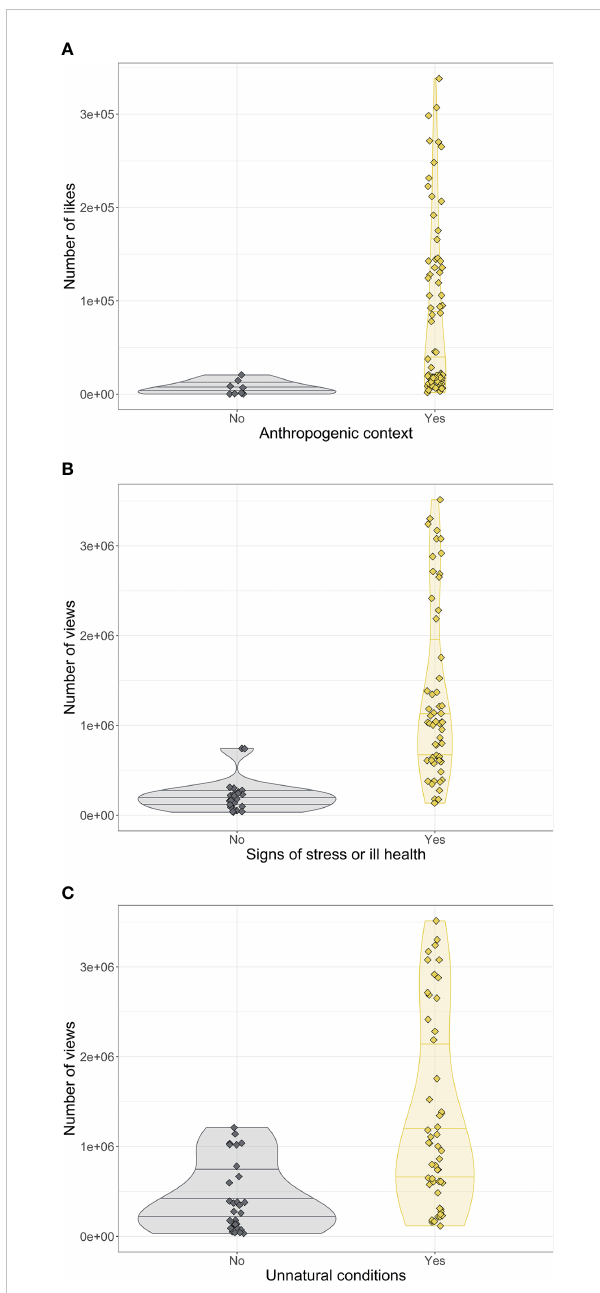
FIGURE 4 Violin plots with jittered data points and quartiles (1 st , median, 3 rd ) representing the predicted model values for signi fi cant predictors in fl uencing the number of likes and views on TikTok and YouTube videos. Videos with anthropogenic context had more likes (A) , videos with signs of stress or ill health (B) and unnatural conditions (C) had more